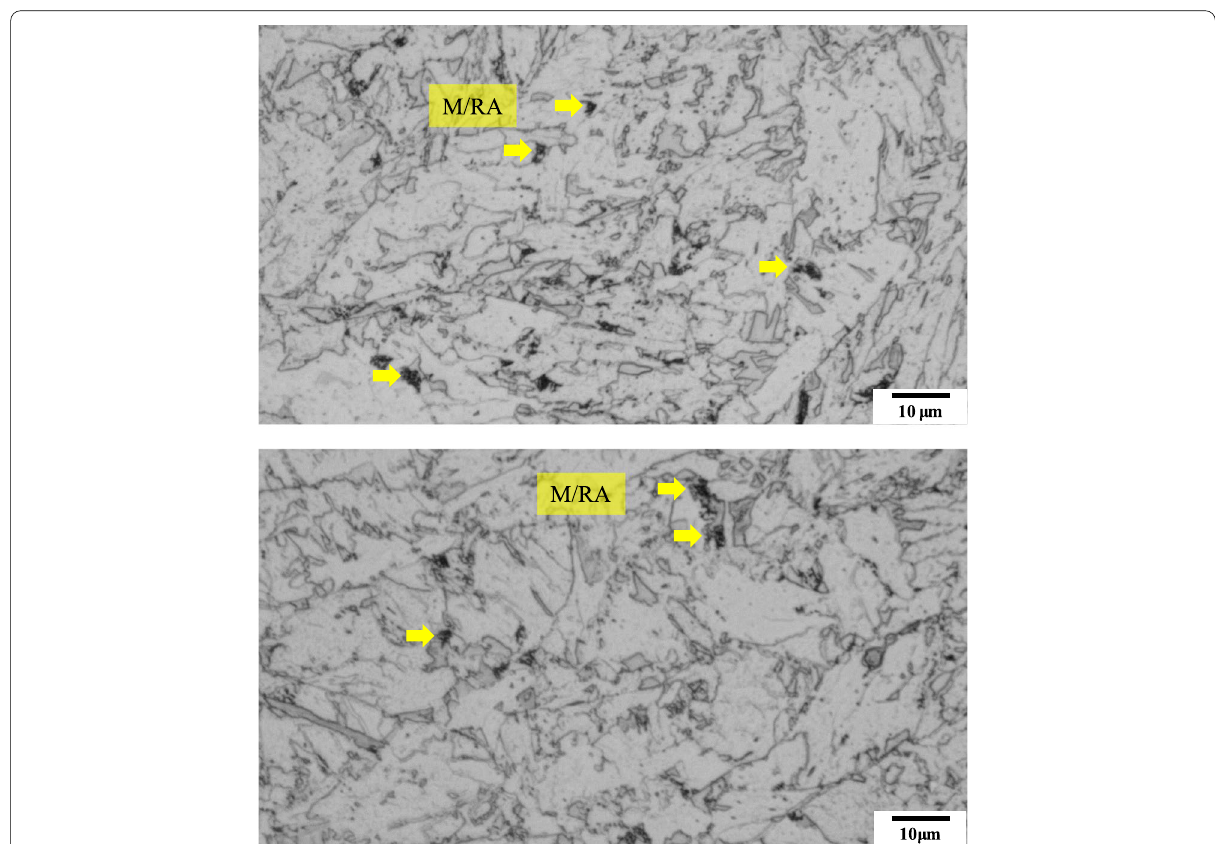
Fig. 2 Optical micrographs subjected to Nital etching of 4Nb specimen. The marked phase is M/RA. But it can’t distinguish the ferrite phase and bainite phase due to similar color (white and